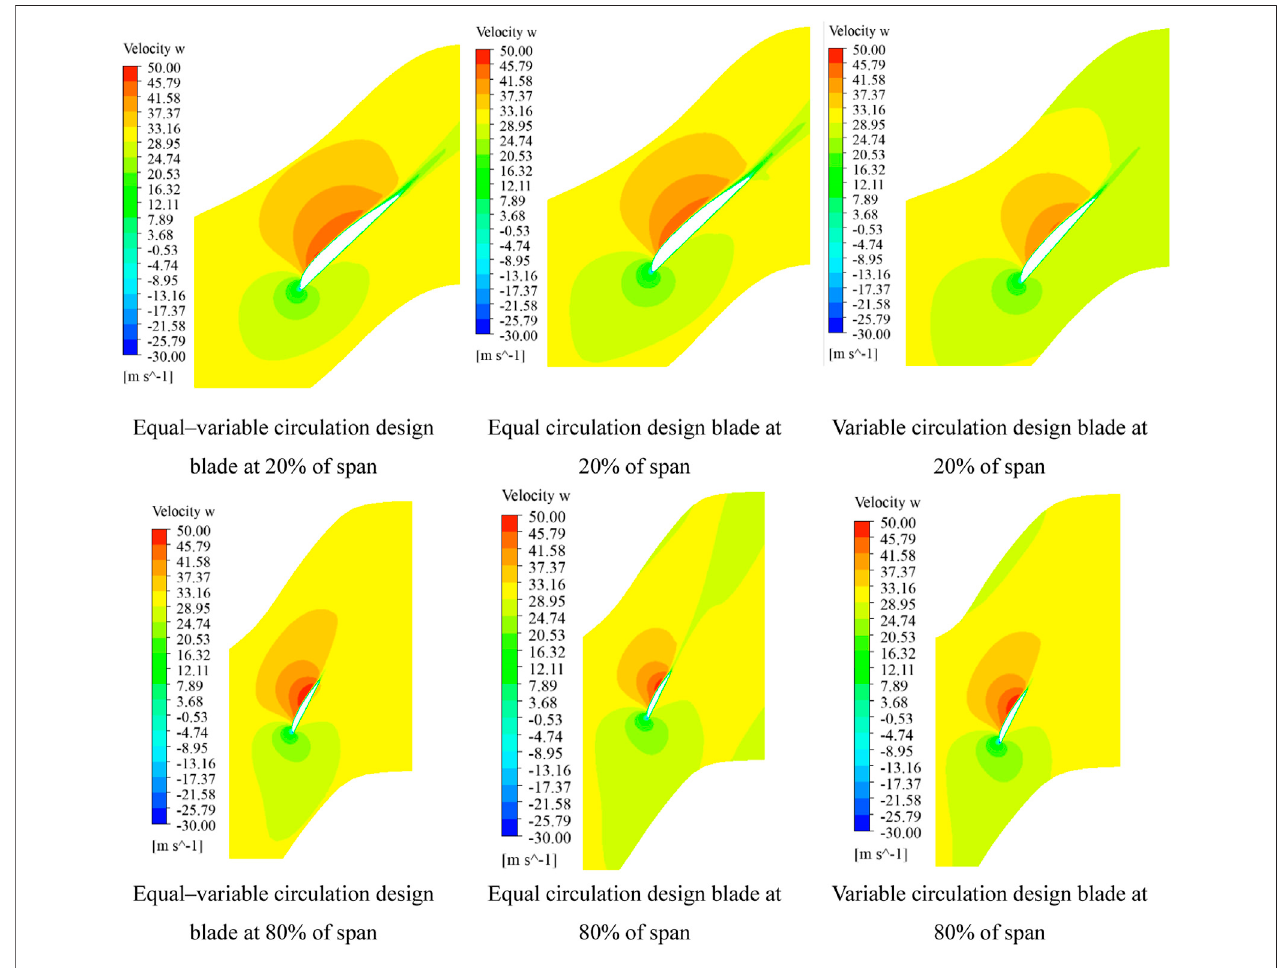
FIGURE 8 | Axial velocity and cross-section streamlines of the three blades at 20 and 80% of the span.